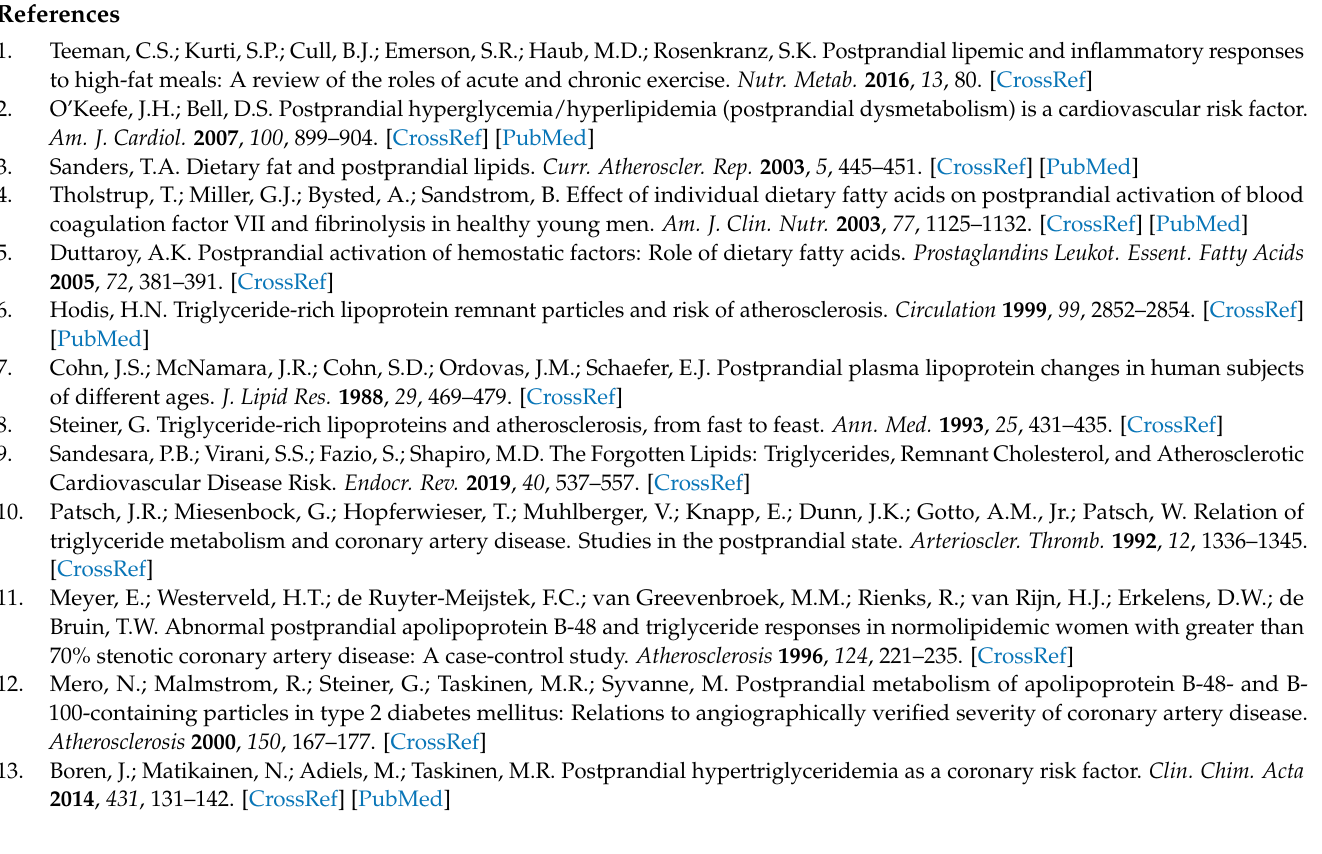
responsive and heritable lipid species Table S2. Expanded replication on chromosome 9 in HAPI Heart; Table S3. Results of the GOLDN sensitivity analysis; Table S4. Regional epigenetic analysis of GWAS findings from Table